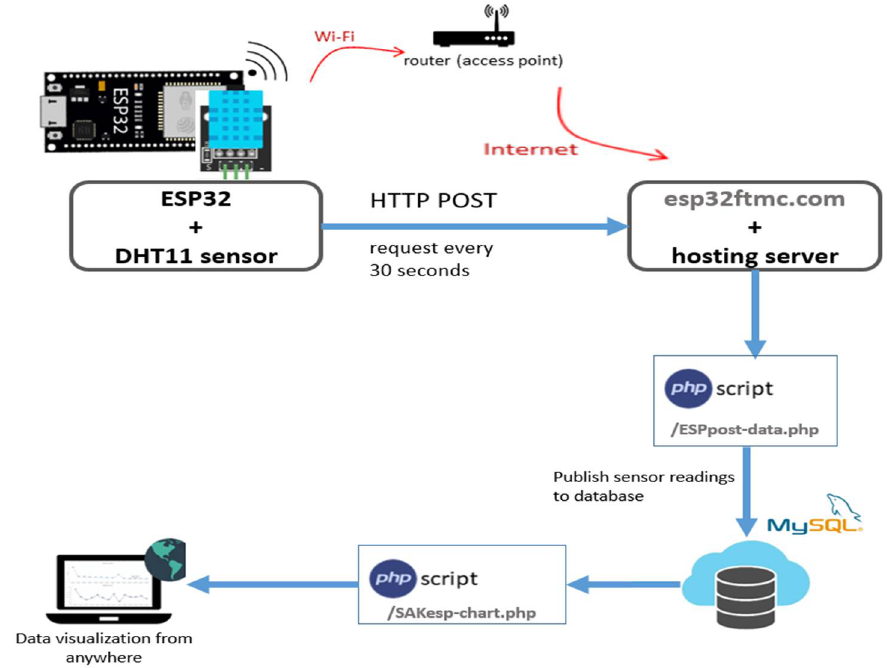
Figure 6. Overview of hosting PHP application and MySQL database.